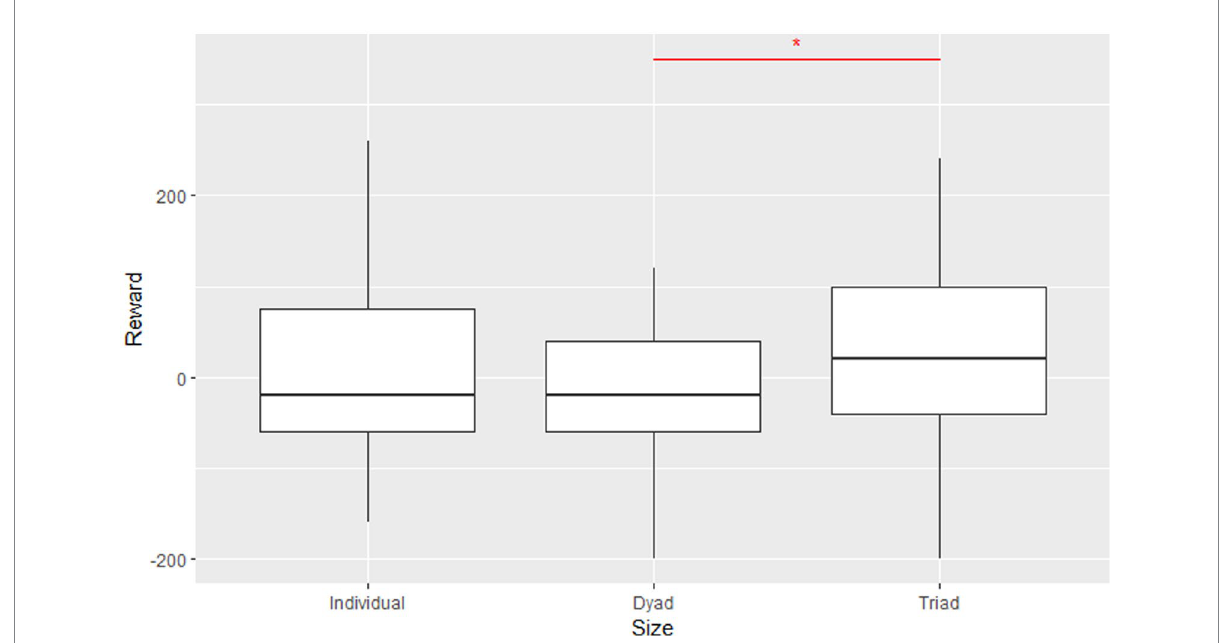
FIGURE 3 Comparison of average performance of individuals, dyads, and triads. Error bars represent standard errors of means. The Kruskal–Wallis test was applied. * p < 0.1.